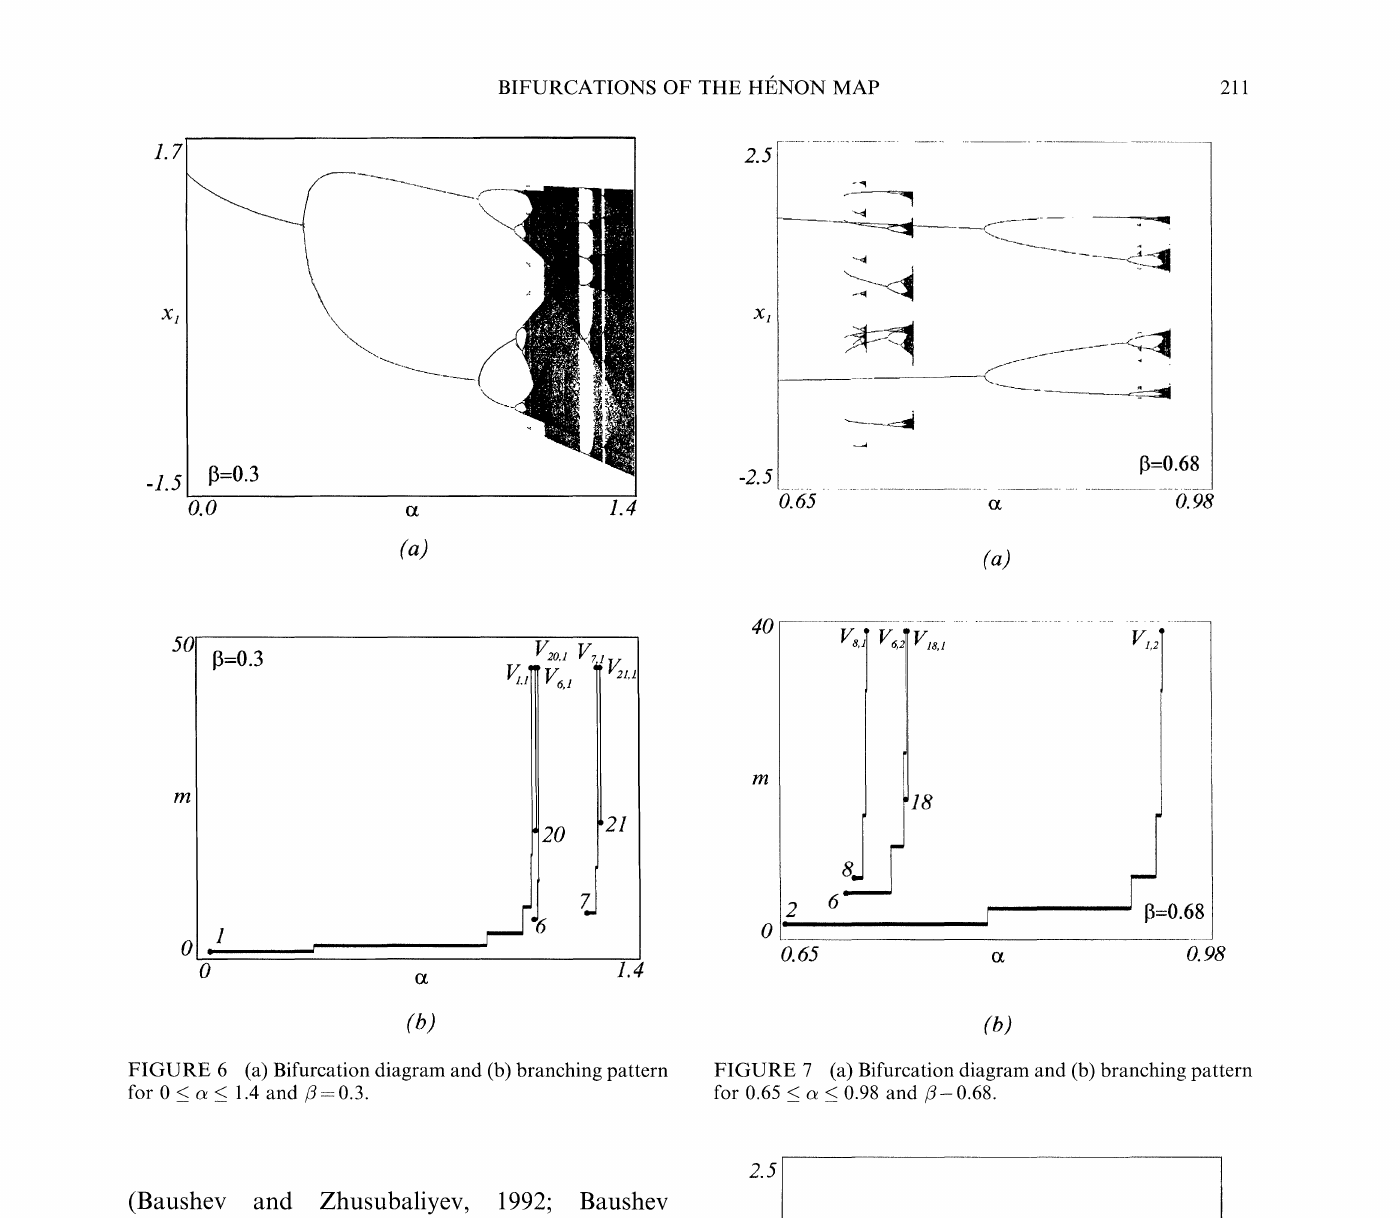
FIGURE 6 (a) Bifurcation diagram and (b) branching pattern for 0 _< c _< 1.4 and/3 0.3.